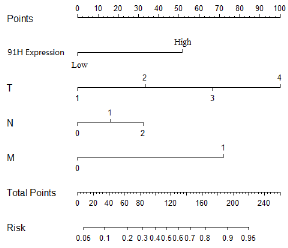
Figure 5. Postoperative nomogram with 91H expression and significant clinicopathologic parameters predicted the proba- bility of CRC for 3-year death.